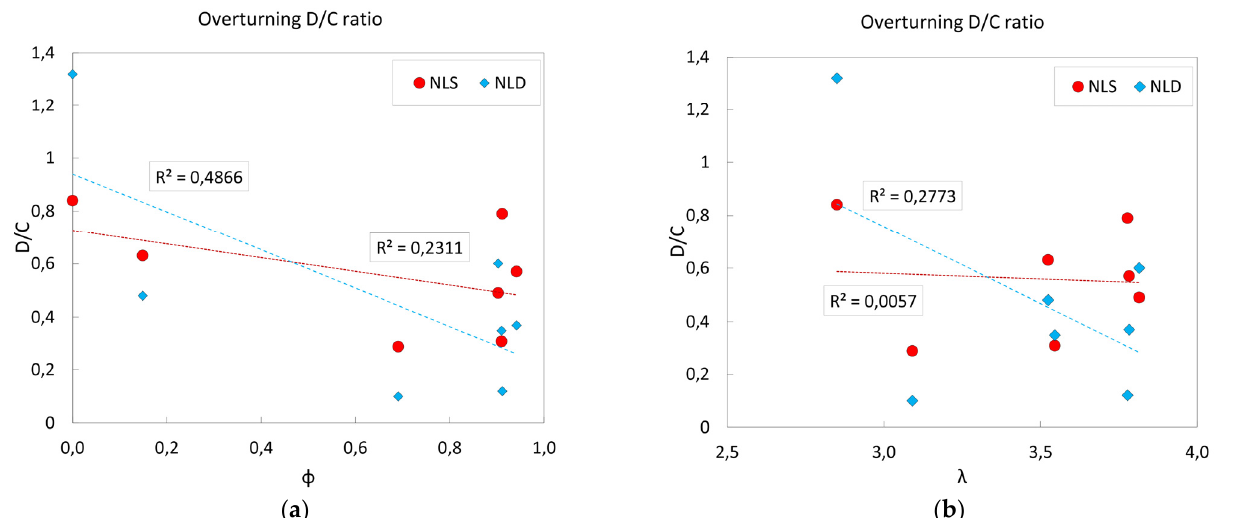
Figure 12. Overturning distribution for a standard section as a function of the filling ratio φ ( a ) and slenderness λ ( b ). Results of the NLS and NLD analyses.